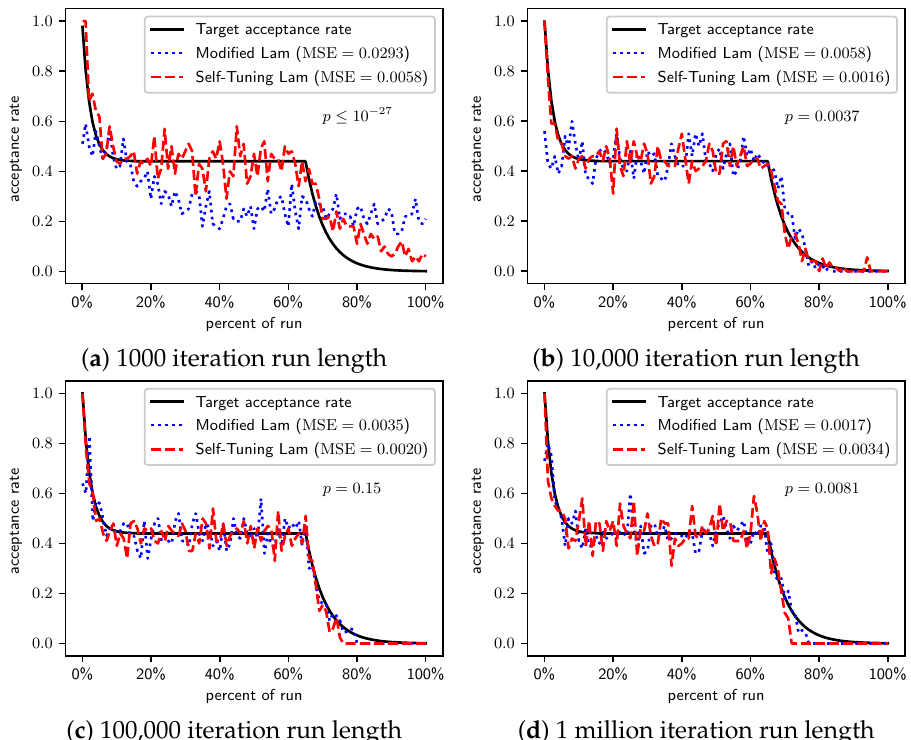
Figure 2. OneMax (each 0-bit costs 1): Self-Tuning Lam, Modified Lam, and target acceptance rates for ( a ) 1000 iterations, ( b ) 10,000 iterations, ( c ) 100,000 iterations, and ( d ) 1 million